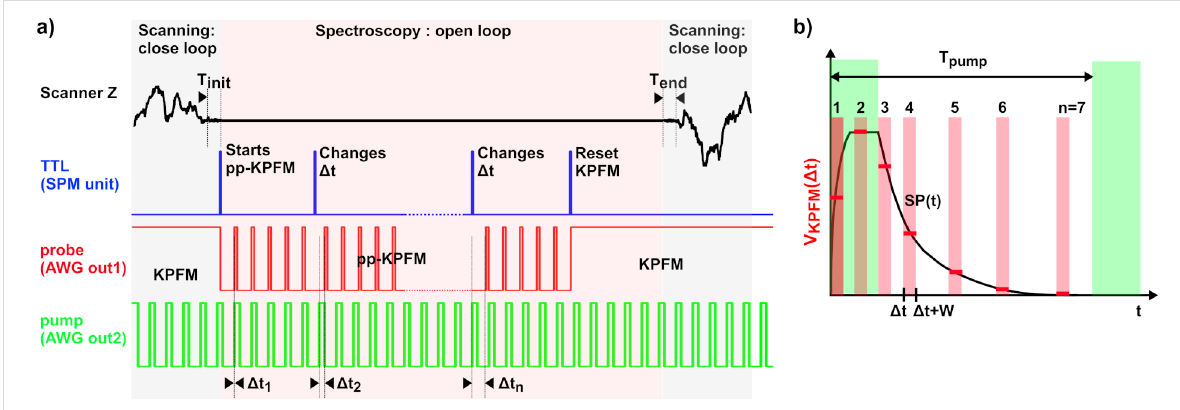
Figure 2: (a) Detail of the spectroscopic sequence implemented for the acquisition of the pp-KPFM signal as a function of the pump–probe delay Δ t . The topographic scan is performed by closed-loop z -regulation simultaneously with “conventional” FM-KPFM imaging. Before recording each spec- troscopic pixel, the tip is stopped. The z -regulation is kept during an initial stabilization delay prior to spectroscopy ( T init ), and then the z -loop is frozen during the spectroscopic ramp. The KPFM configuration is changed to pp-KPFM by the first TTL pulse, and each subsequent TTL pulse changes the pump–probe delay. The last TTL pulse resets the setup configuration in conventional KPFM. The z -regulation is reactivated, and nc-AFM/KPFM scan- ning resumes after a final stabilization delay ( T end ). (b) Illustration of a spectroscopic curve acquired in the case of optical pumping. The instanta- neous surface potential SP( t ) is symbolized by the black line. V KPFM ( Δ t ) curves are acquired for a predefined number of discrete pump–probe delays. Note that the Δ t values can be either evenly or irregularly distributed. The time-resolution is fixed by the width ( w ) of the probe pulses. The horizontal red bars represent the pp-KPFM potential. It is equal to the time-integral value of SP( t ) normalized by w over the interval Δ t − Δ t + w